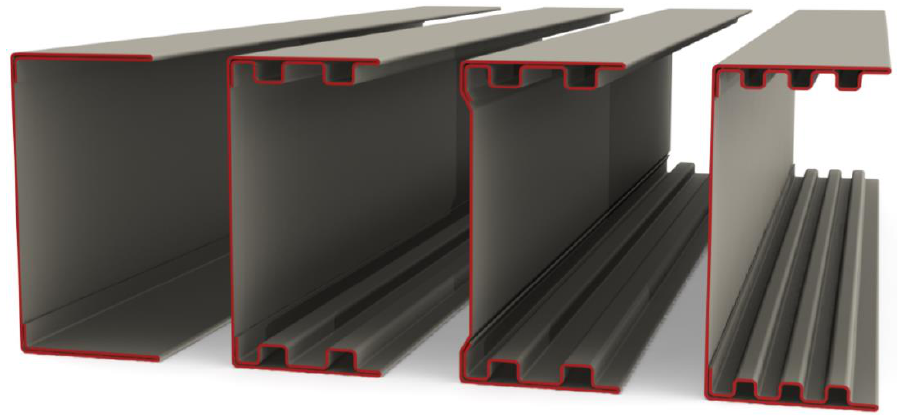
Figure 1. Shapes of cross-sections of tested columns.